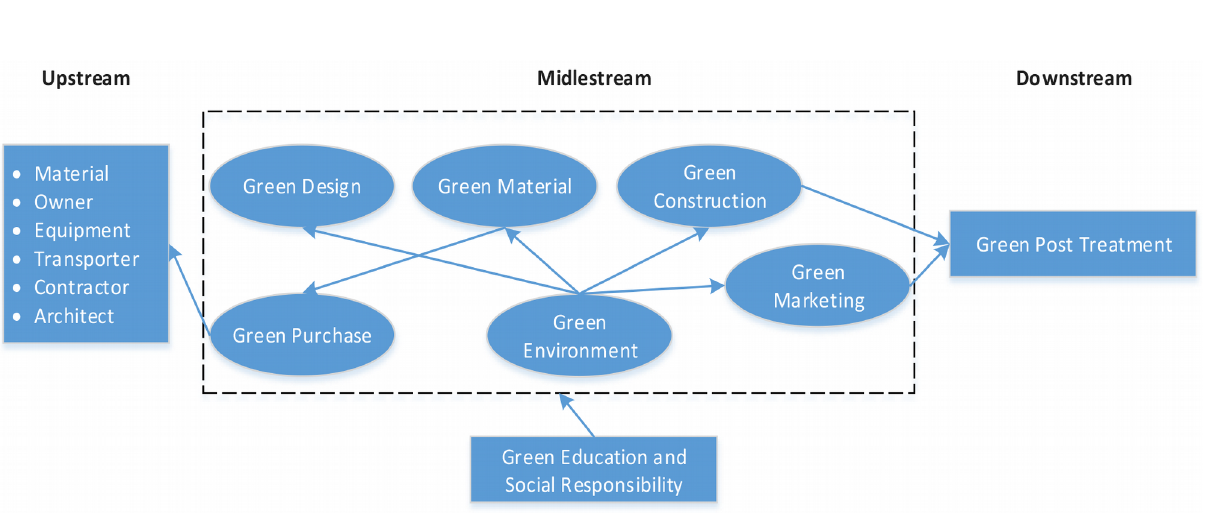
Figure 1. Value chain construction industry (Ghobakhloo et al.,